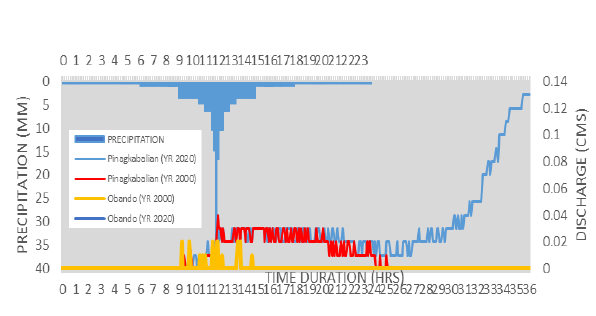
Figure 4.20 Downstream